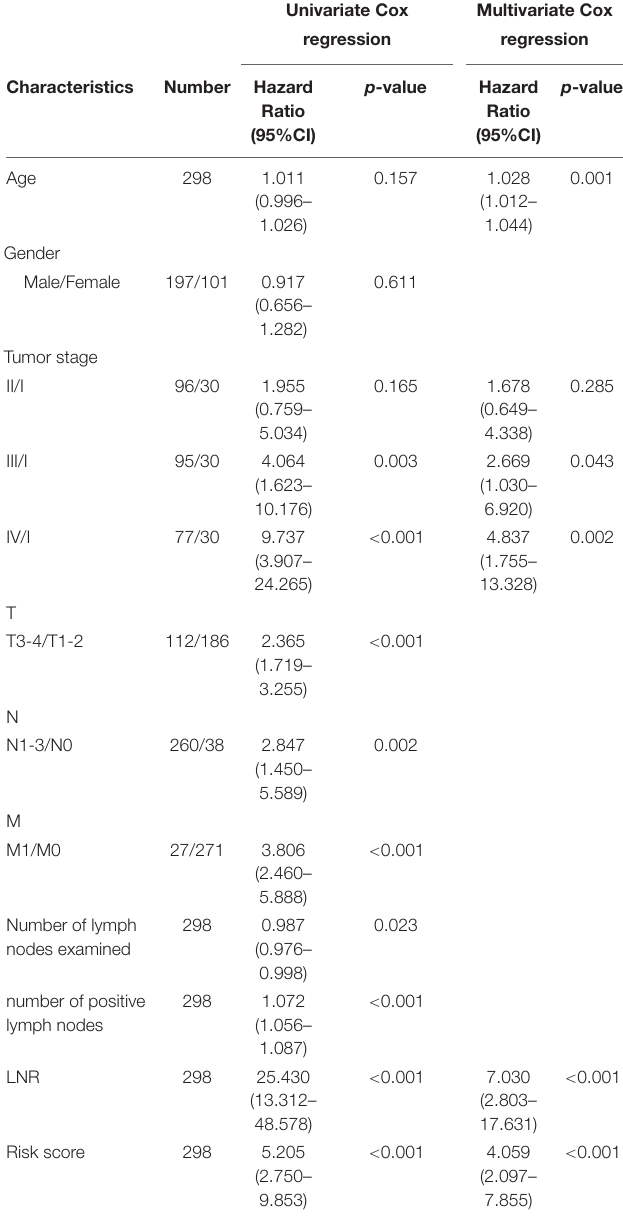
TABLE 2 | Univariate and multivariate Cox regression analyses of clinical characteristics and risk score in GSE62254. Univariate Cox Multivariate Cox regression regression